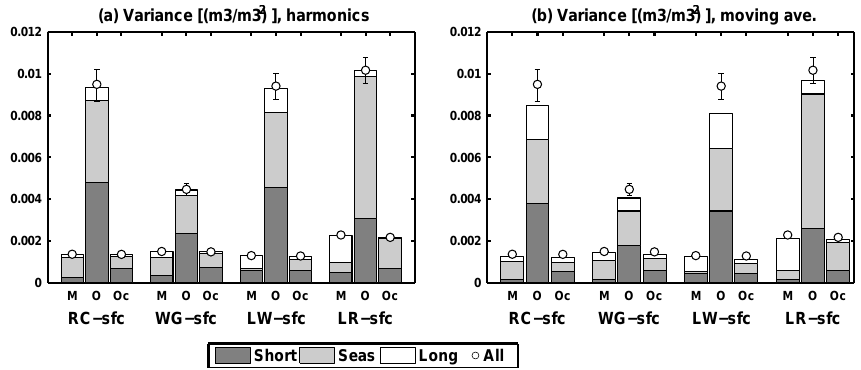
Figure 3. Time series variance at each timescale, with the Catchment Model (M), original AMSR-E Observed (O), and CDF-matched AMSR-E Observed (Oc) soil moisture variances plotted for the (a) harmonic, and (b) moving average decomposition methods. The circles and error bars give the variance of the original soil moisture time series, with 95% confidence intervals (some very small confidence intervals are obscured by the plotted